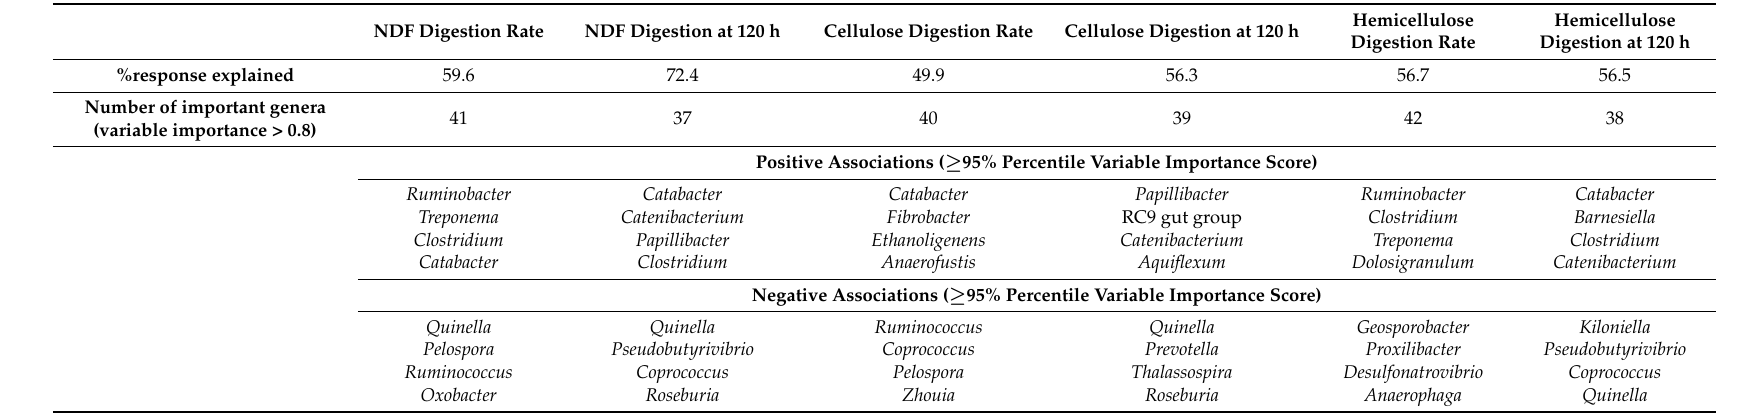
Table 5. Main bacterial genera associated with fiber digestion in